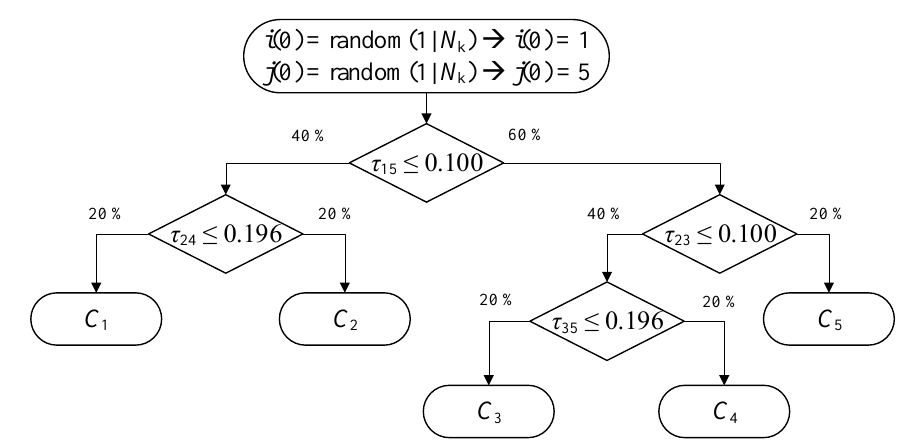
Figure 3. Simple example of a decision tree with 5 clusters. Depending on the TDoA measurements a cluster can be